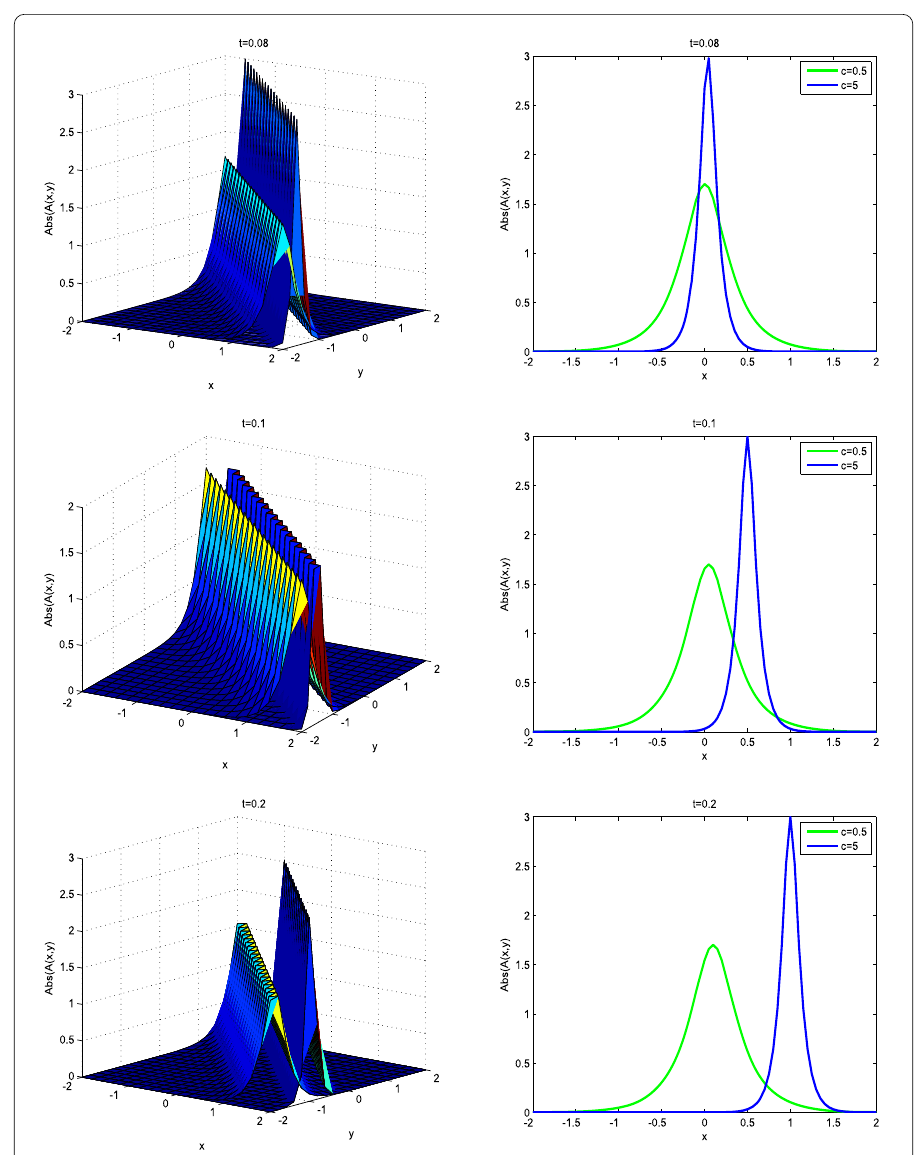
Figure 2 The collisions between two waves with different velocities for c = 0.5 and c = 5, respectively, and various timescales for t = 0.08, t = 0.1, and t = 0.2,